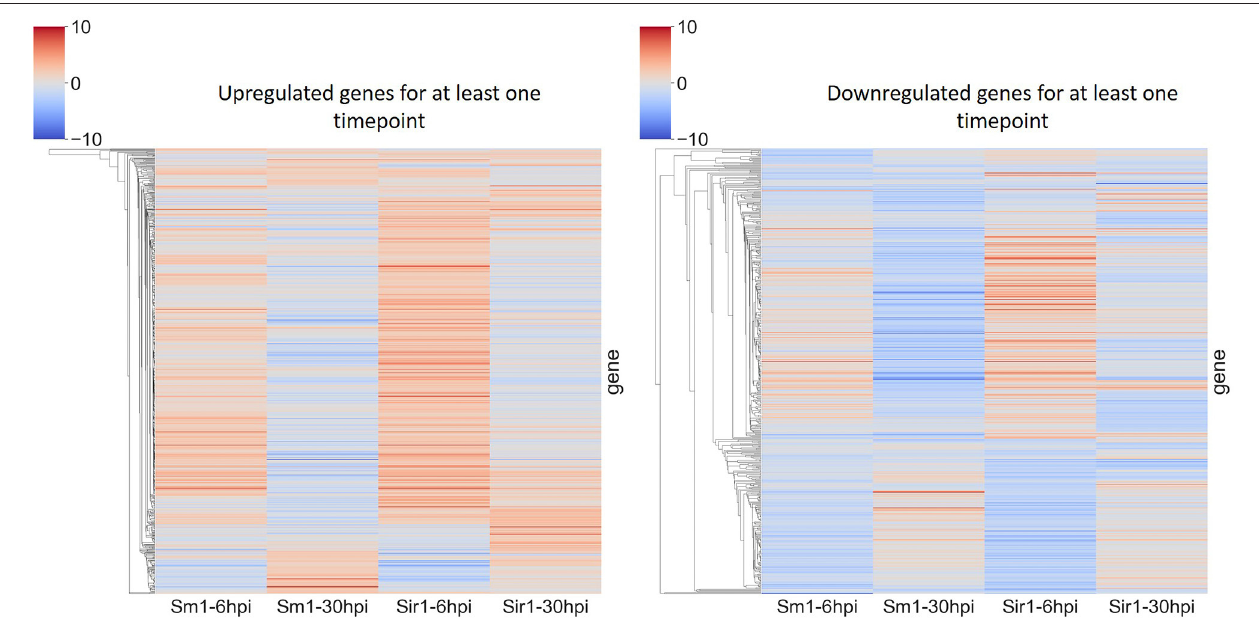
FIGURE 4 | Heatmap comparison of differential gene expression from 1 sm1 or 1 sir1 mutants at 6 and 30 hpi. This comparison shows all genes that were differentially expressed during at least one time point. The color gradient from blue to red represents differential expression (log2-fold change), downregulation in blue and upregulation in